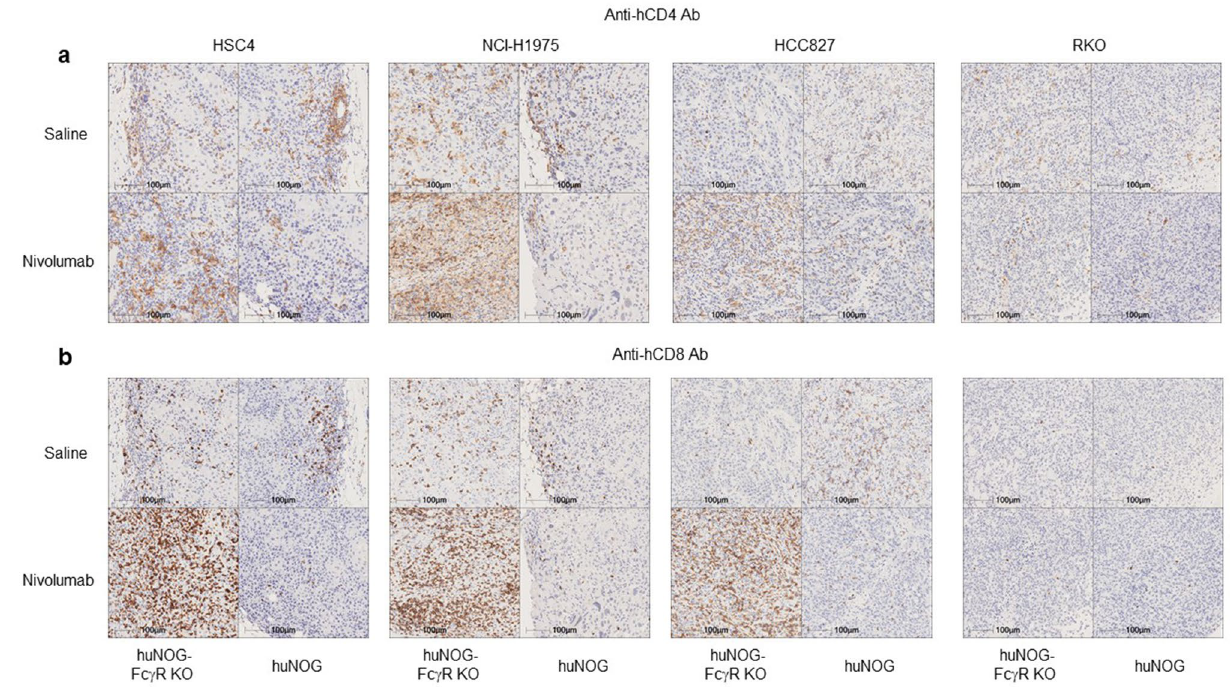
Figure 4. IHC of tumors from huNOG or huNOG-FcγR −/− mice. Tumors were excised from huNOG or huNOG-FcγR −/− mice 1–2 days after the last administration of nivolumab or saline. Half of the tumor was fixed in 10% neutralized formalin and subsequently subjected to IHC analyses after embedding in paraffin. Tumor sections of HSC4, HCC827, NCI-H1975, and RKO cells were stained with anti-human CD4 ( a ) or